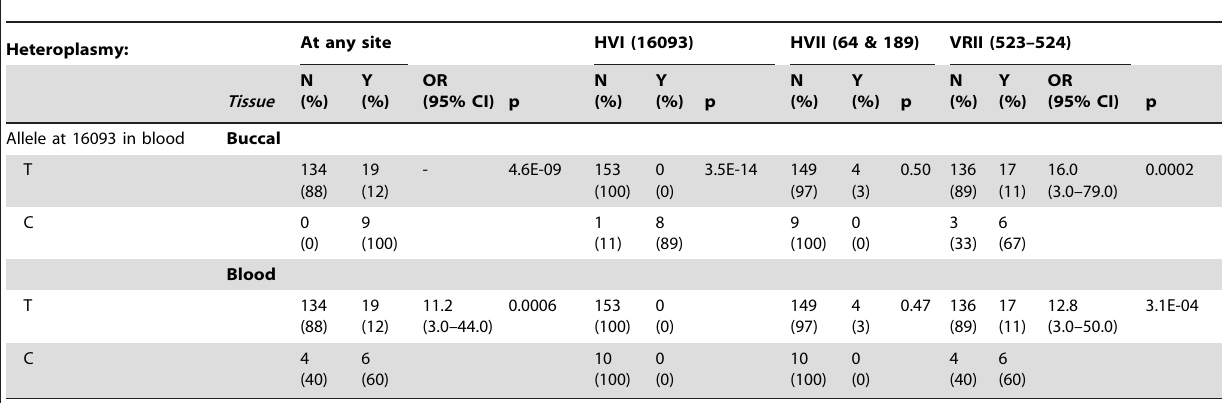
Table 5. Genetic association between the fixed minor allele at HVI site 16093 observed in blood and heteroplasmy in both tissue samples (buccal swab and